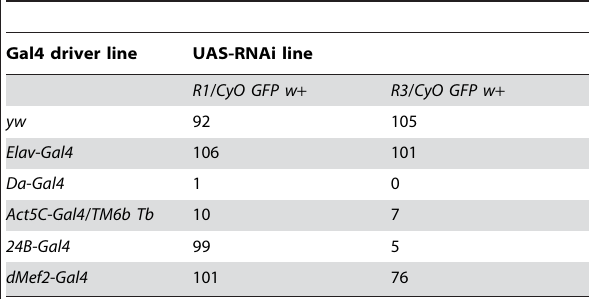
Table 1. Viability of Drosophila with induced RNAi (%)